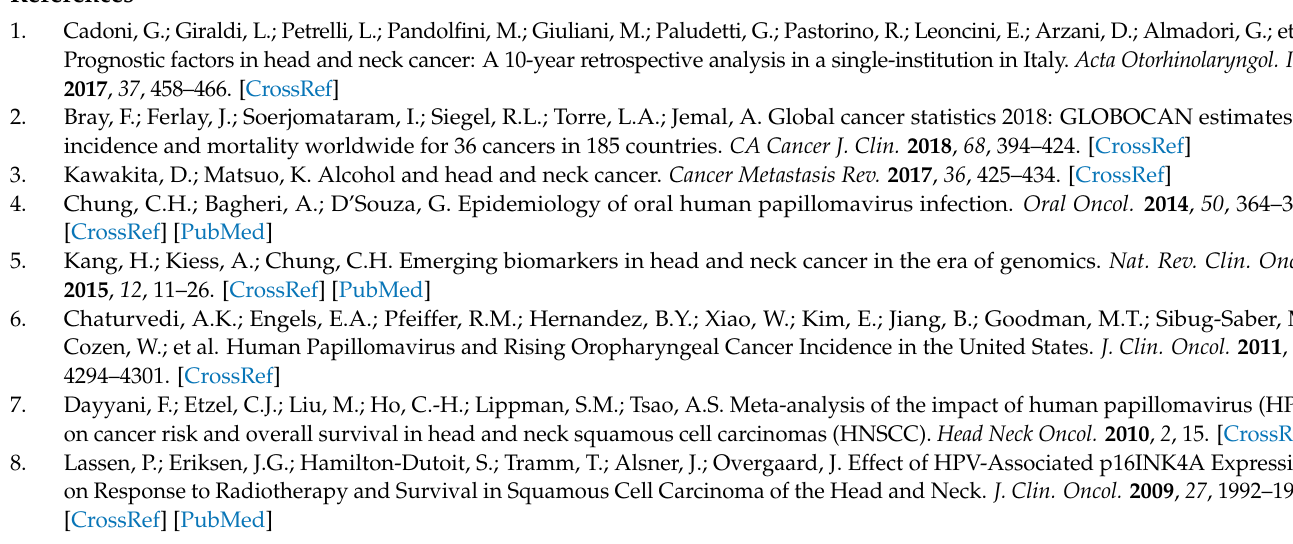
and resistance cells, Figure S2: IGF2 silencing using siRNA, Figure S3: Characterizing of the cellular response of tumor cells to therapy combination, Figure S4: Cleaved Caspase3 staining, Figure S5: Toxicity of therapy in mice, Figure S6: IGF2 expression HNC patients, Figure S7: AXL and HER3 expression in sensitive and resistant cells. Figure S8: Original western blot images, Table S1: Up and down regulated gene analysis, Table S2: Clinical trials